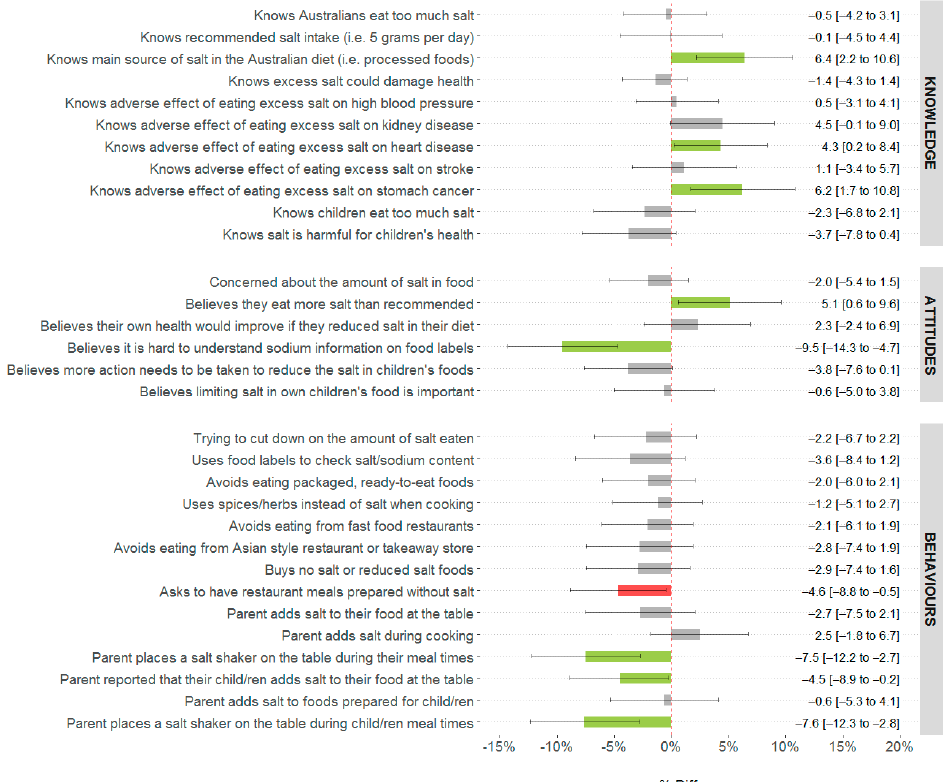
Figure 3. Difference in knowledge, attitudes and behaviors related to dietary salt among parents of children aged <18 years residing in the state of Victoria, Australia following a salt reduction consumer awareness campaign 1, 2, 3 . 1 . Analysis weighted to represent Victorian population (Census 2016) for age and sex [24]. 2 . Data are mean [95%CI] and values are adjusted for country of birth, educational attainment, diagnosed with chronic condition, received advice from a health professional to reduce salt intake and responsibility for household grocery shopping. 3 . Color legend for change in KABs: green bars represent a significant ( p < 0.05) positive improvement; red bars represent a significant worsening; grey bars represent no change.